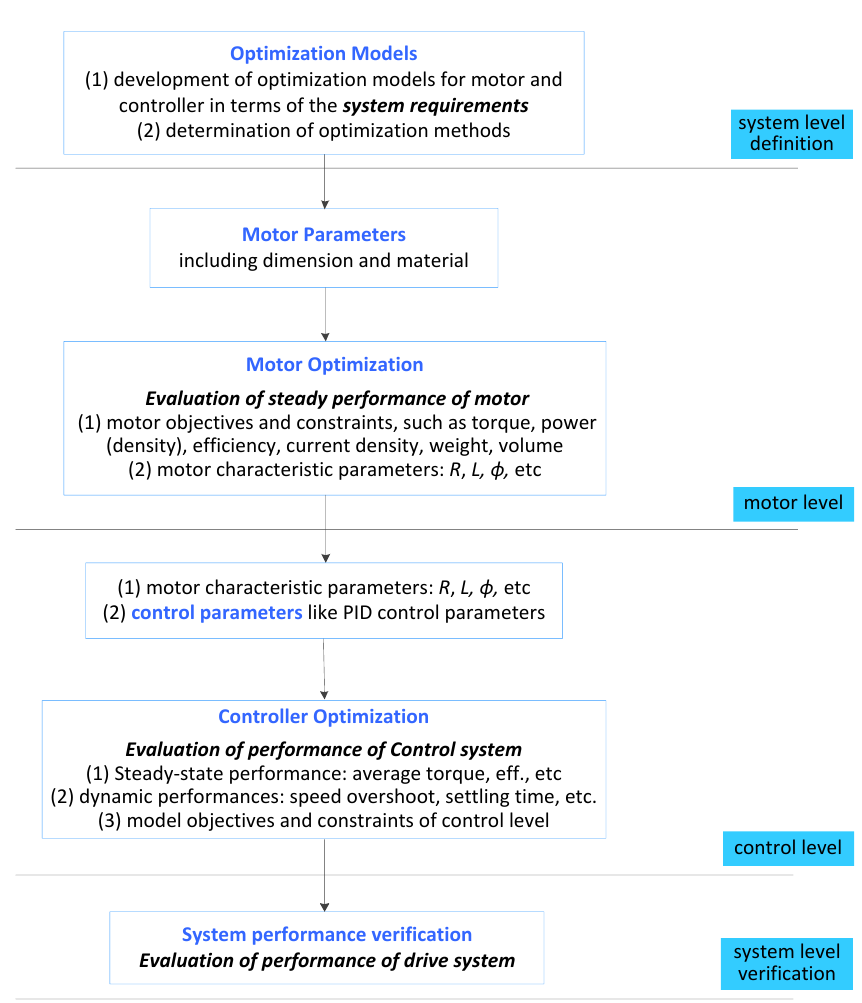
Figure 12. Multi-level optimization method for an electrical drive system.